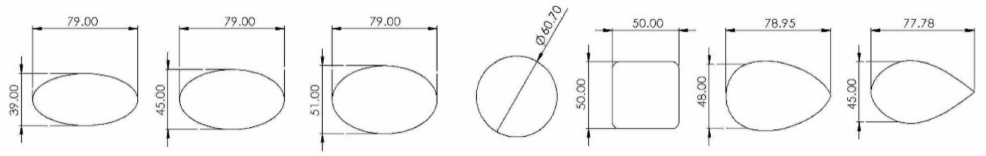
Figure 7. Down tube cross-sections from left to right: oval 39 × 79, oval 45 × 79, oval 51 × 79, circular 60.7 mm, rectangular 50 × 50, complex 1, and complex